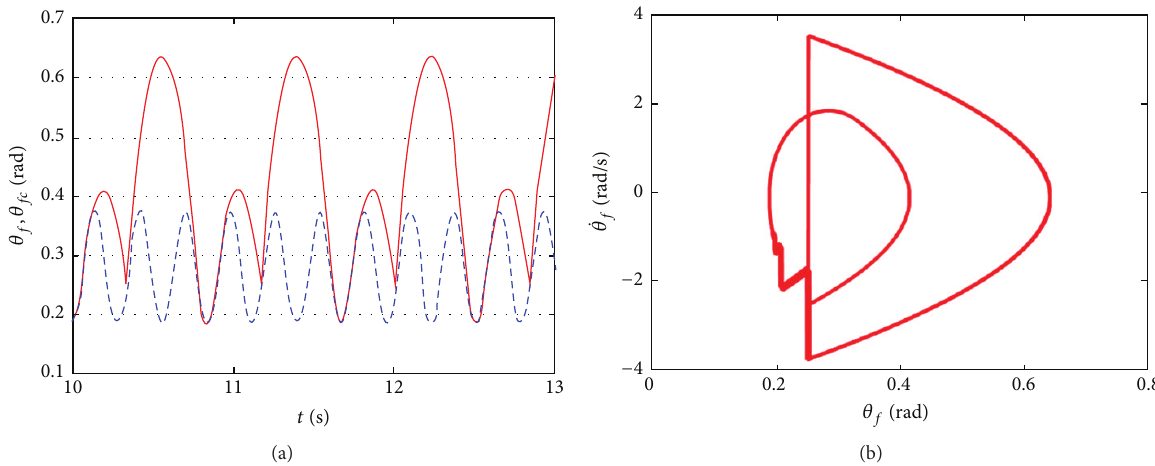
Figure 8: 𝑃(∞,2) motion when 𝜔 = 22.5 rad/s: (a) time history of 𝜃 𝑓 (solid line) and 𝜃 𝑓𝑐 (dashed line) and (b) phase diagram.